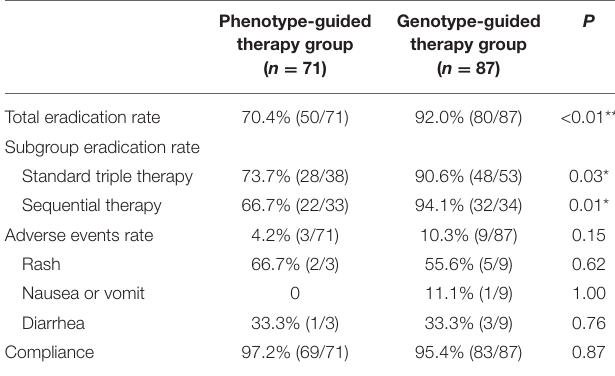
TABLE 3 | The results of phenotype tested by E-test and genotype detected by PCR sequencing of H. pylori for clarithromycin.